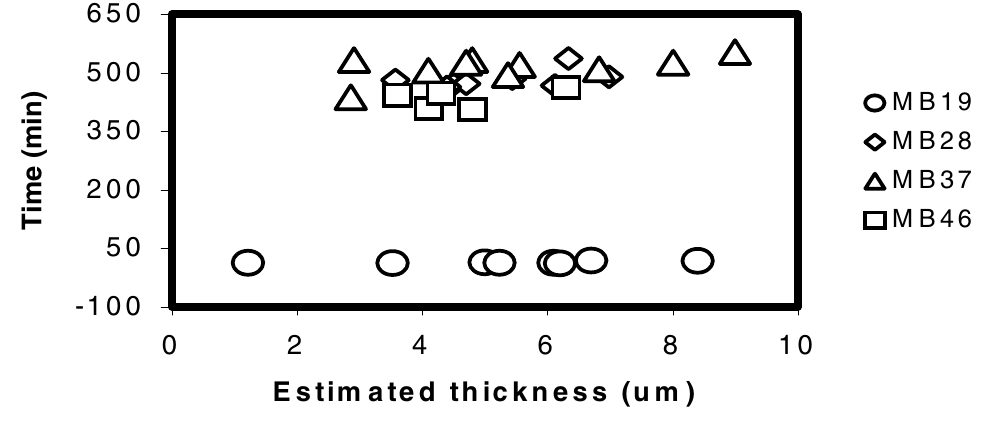
Figure 1. The time taken for different types of copolymer films to detach from the glass slides after immersed in Tris(HCl) buffer pH=7 with respect to the calculated